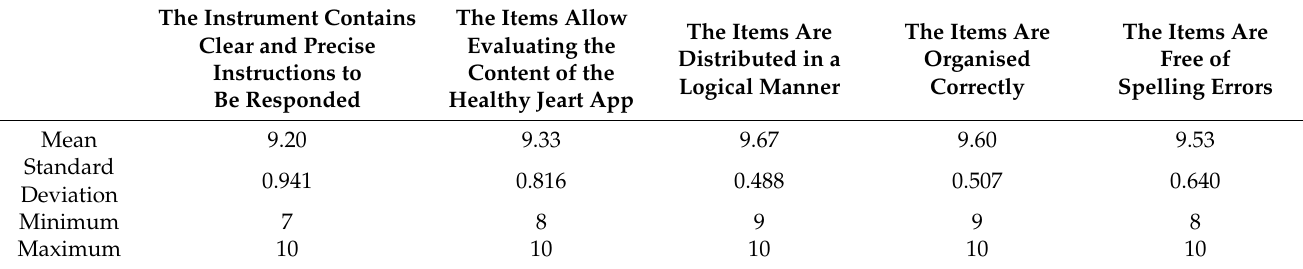
Table 1. Descriptive statistics derived from the validation of the content through the expert